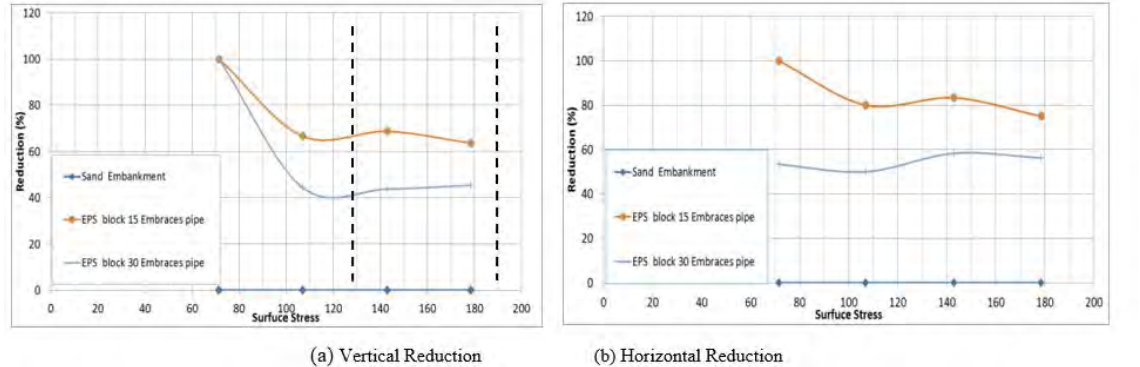
Figure 10. The reduction percentage of UPVC buried pipe incase of EPS embraces upper pipemethods.